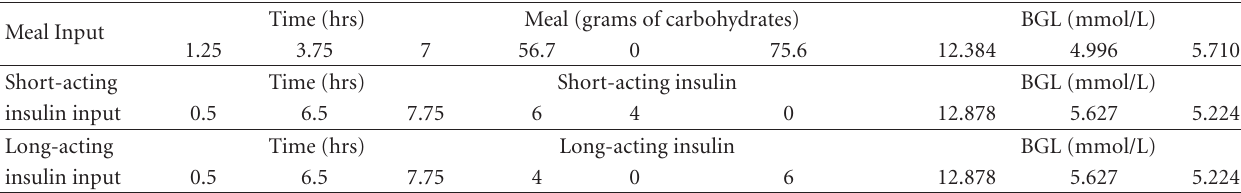
Table 3: Sample of the data used for training and testing of the ANNs for the long-term predictions (note that 0.00 hrs represents midday and 12.00 hrs represents